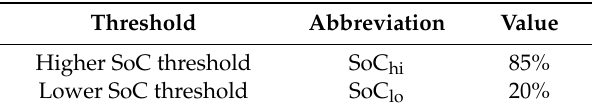
Table 3. SoC thresholds for respecting the 30 min